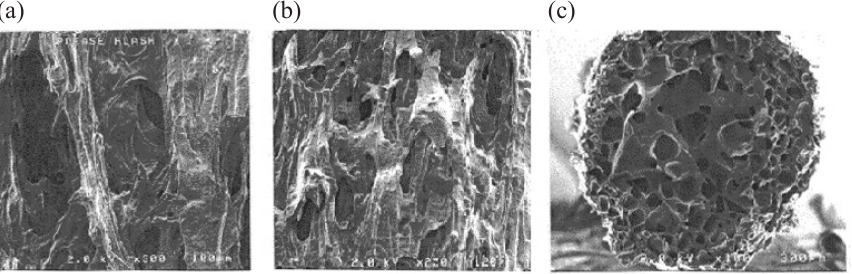
Fig. 7. SEM micrographs of the